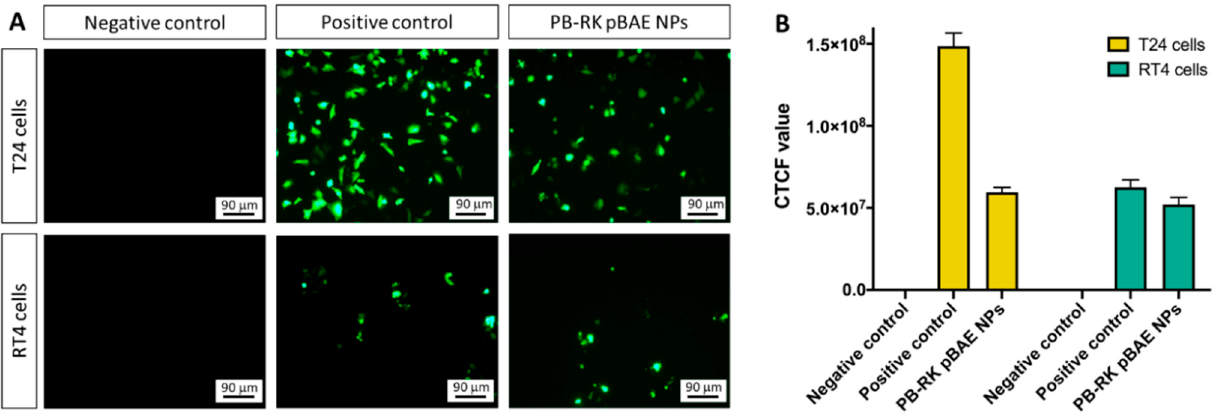
Figure 6. Nanoparticles transfection. ( A )—Micrographies of T24 and RT4 cells, after being incubated with 0.03 mg/mL pGFP,